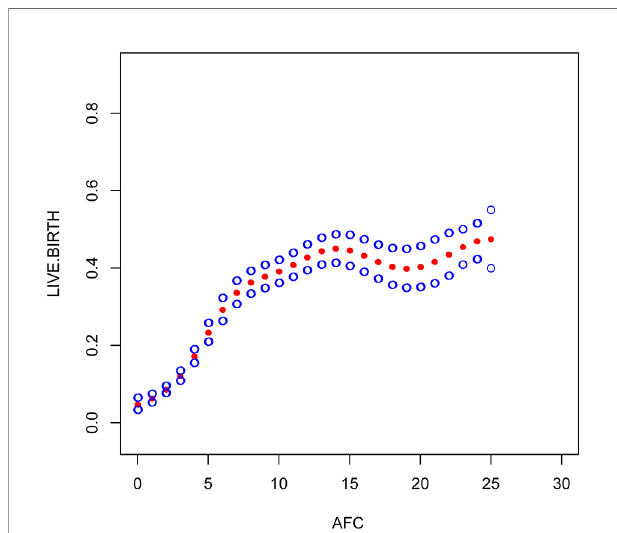
FIGURE 3 | Association between live birth and AFC. A threshold, nonlinear association between live birth and these independent predictive factors was found in a generalized additive model (GAM). Solid rad line represents the smooth curve fi t between variables. Blue bands represent the 95% of con fi dence interval from the fi